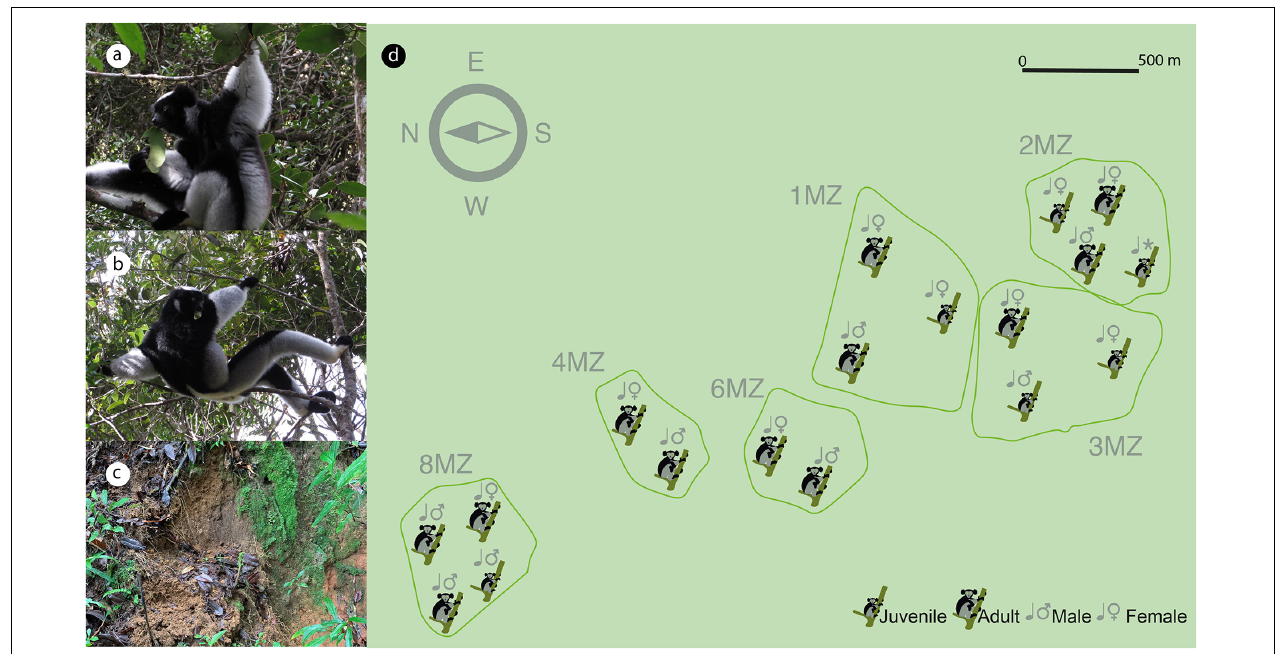
FIGURE 1 | Distribution of the territories occupied by the indri family groups sampled (main figure, d ) and composition of each single group. Both adult and youngster indris, both sexes, feed on leaves (a,b) and perform geophagic behavior, eating soil in specific sites (c) .